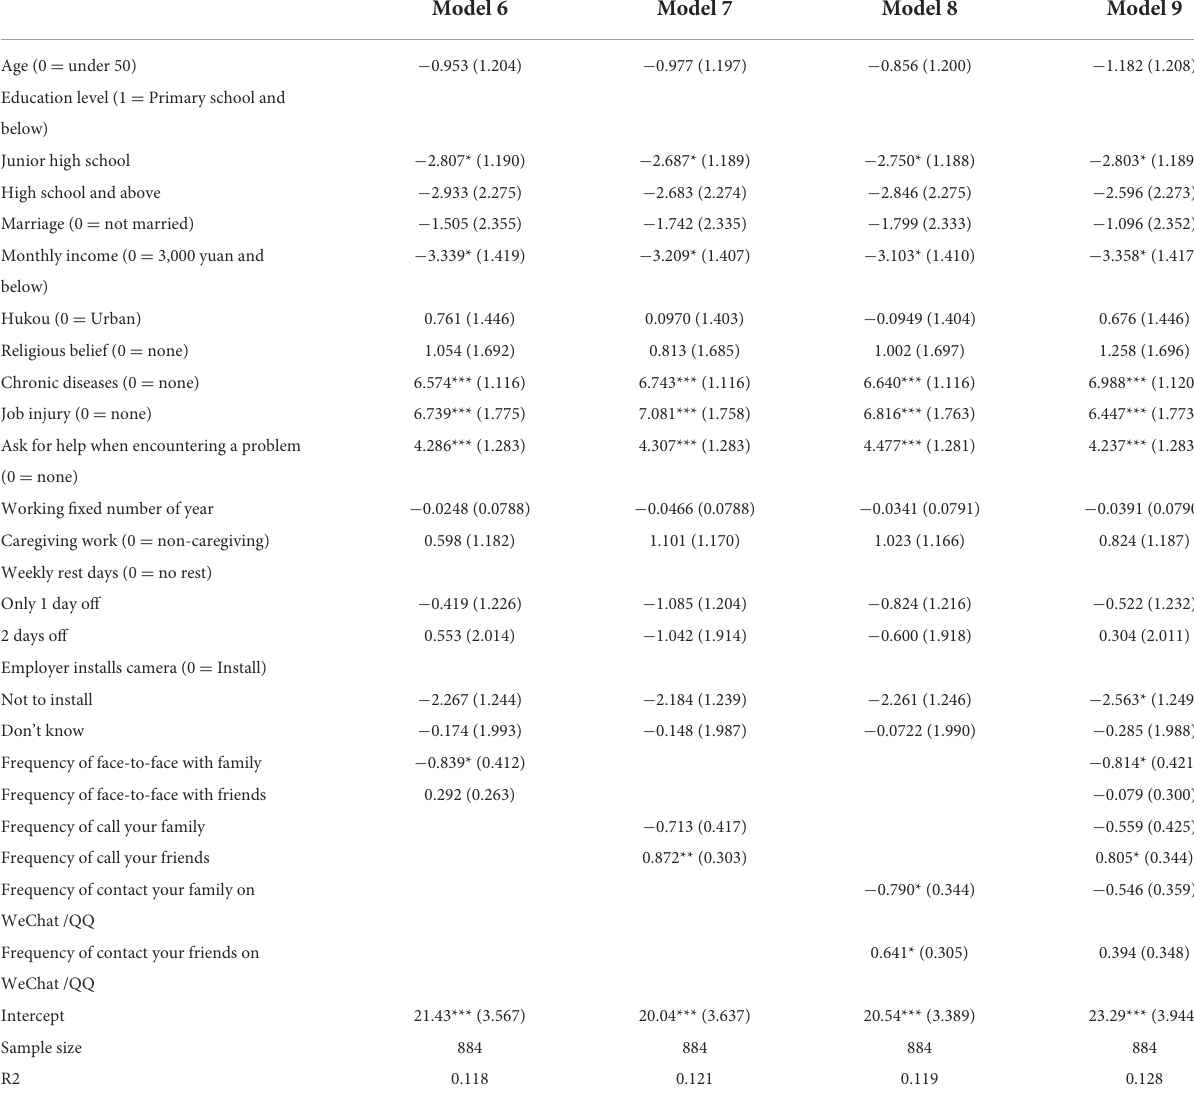
TABLE 5 Regression results of social network in different interactive channels on mental health of domestic